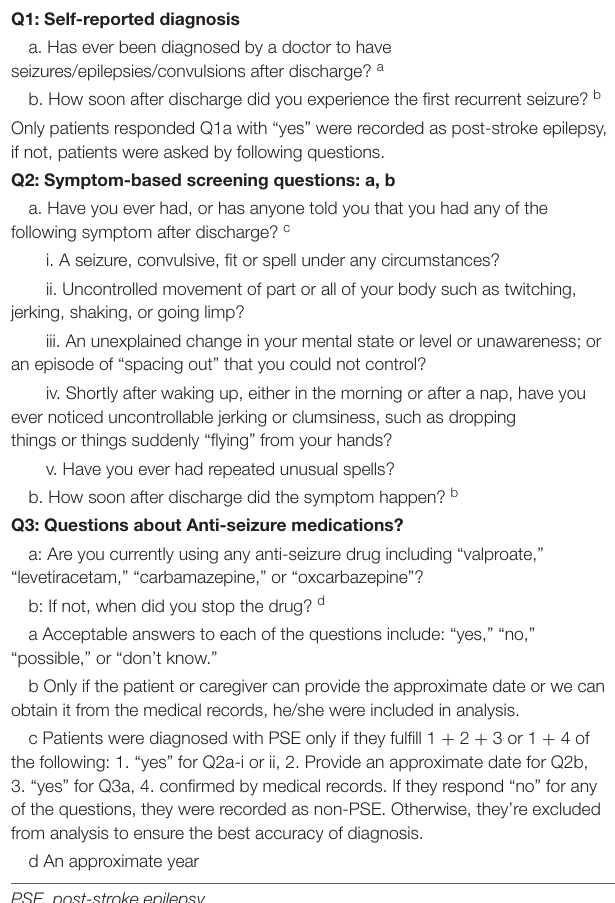
TABLE 1 | Post-stroke epilepsy screening questionnaire. Q1: Self-reported